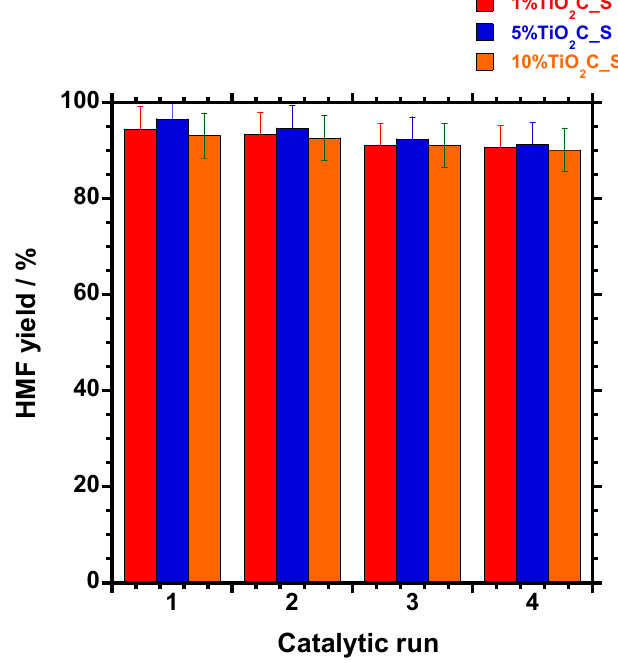
Figure 9. Recycling of the 1%TiO 2 C_S, 5%TiO 2 C_S, and 10%TiO 2 C_S acid catalysts used in the dehydration of fructose into HMF. Conditions: reaction time = 60 min, reaction temperature = 120 ◦ C, catalyst concentration = 0.1 g, amount of fructose = 0.5 g, volume of DMSO = 6 mL).